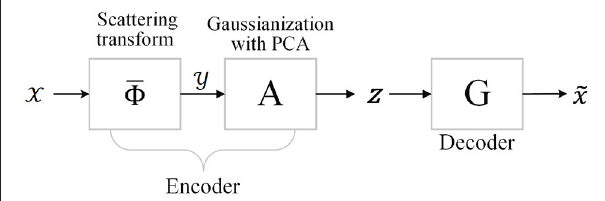
FIGURE 1 | Structure of generative scattering networks (GSNs) with principal component analysis (PCA) dimensionality reduction